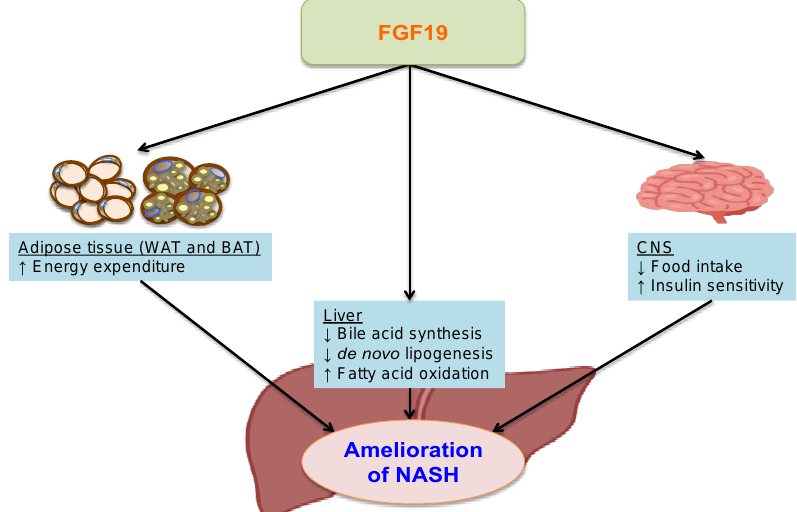
Figure 2. The putative beneficial effects of FGF19 on the pathogenesis of NASH. In the liver, fibroblast growth factor (FGF) 19 suppresses bile acid synthesis, increases fatty acid oxidation and suppresses de novo lipogenesis. In adipose tissue, elevated FGF19 in brown adipose tissue enhances energy expenditure, and in the central nervous system (CNS), FGF19 reduces food intake and improves insulin sensitivity. Overall, these pleiotropic effects of FGF19 ameliorate hepatic steatosis, bile acid toxicity and lipotoxicity, thereby exerting beneficial effects on the pathogenesis of non-alcoholic steatohepatitis (NASH).